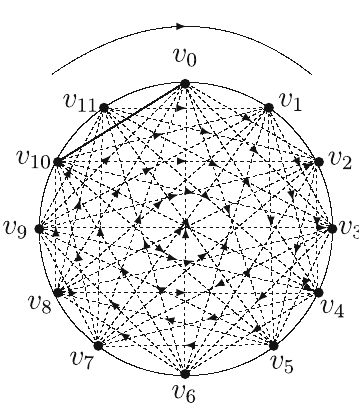
Figure 7: An example for Theorem